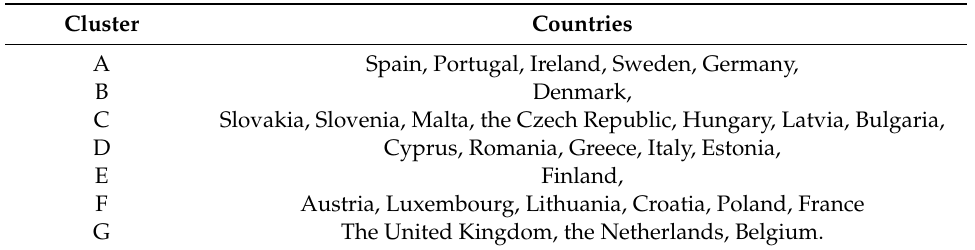
Table 4. Division of the EU countries into clusters similar to each other in terms of development level and wind energy potential.